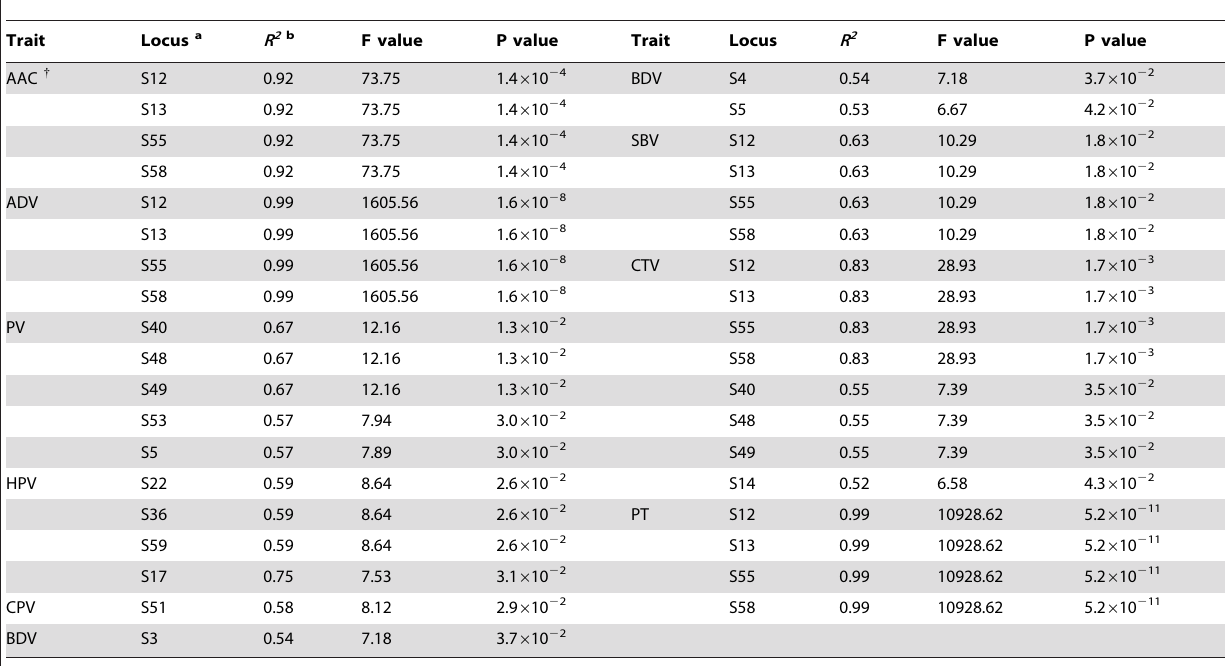
Table 3. Highly associated SNPs and insertion-deletions with eating quality properties identified under general linear model.